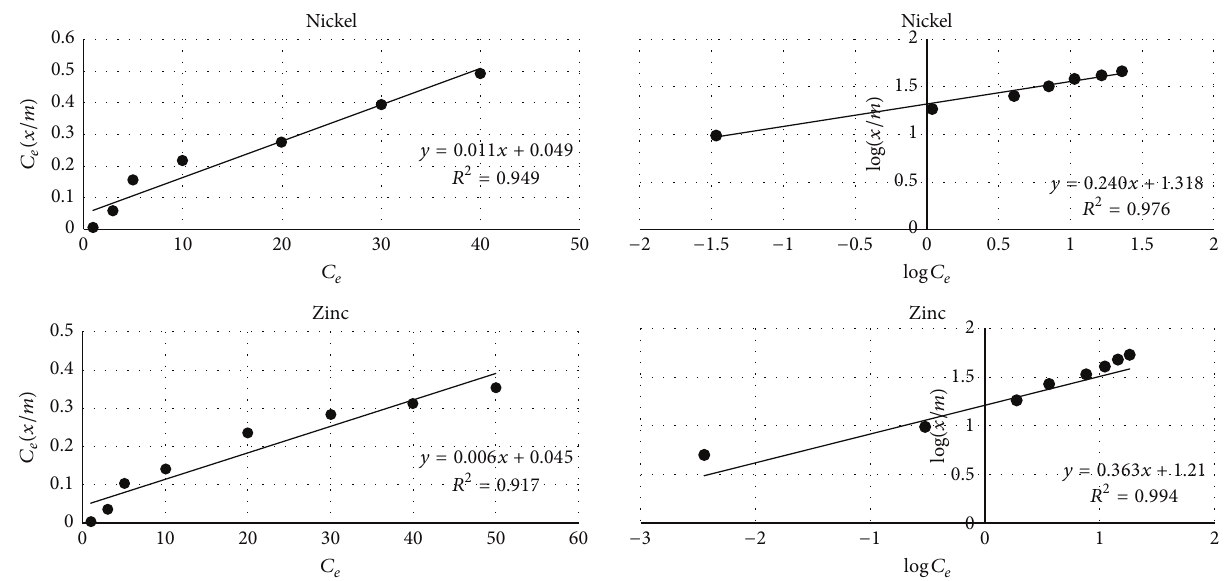
Figure 8: Langmuir and Freundlich isotherms for the adsorption of Ni 2+ and Zn 2+